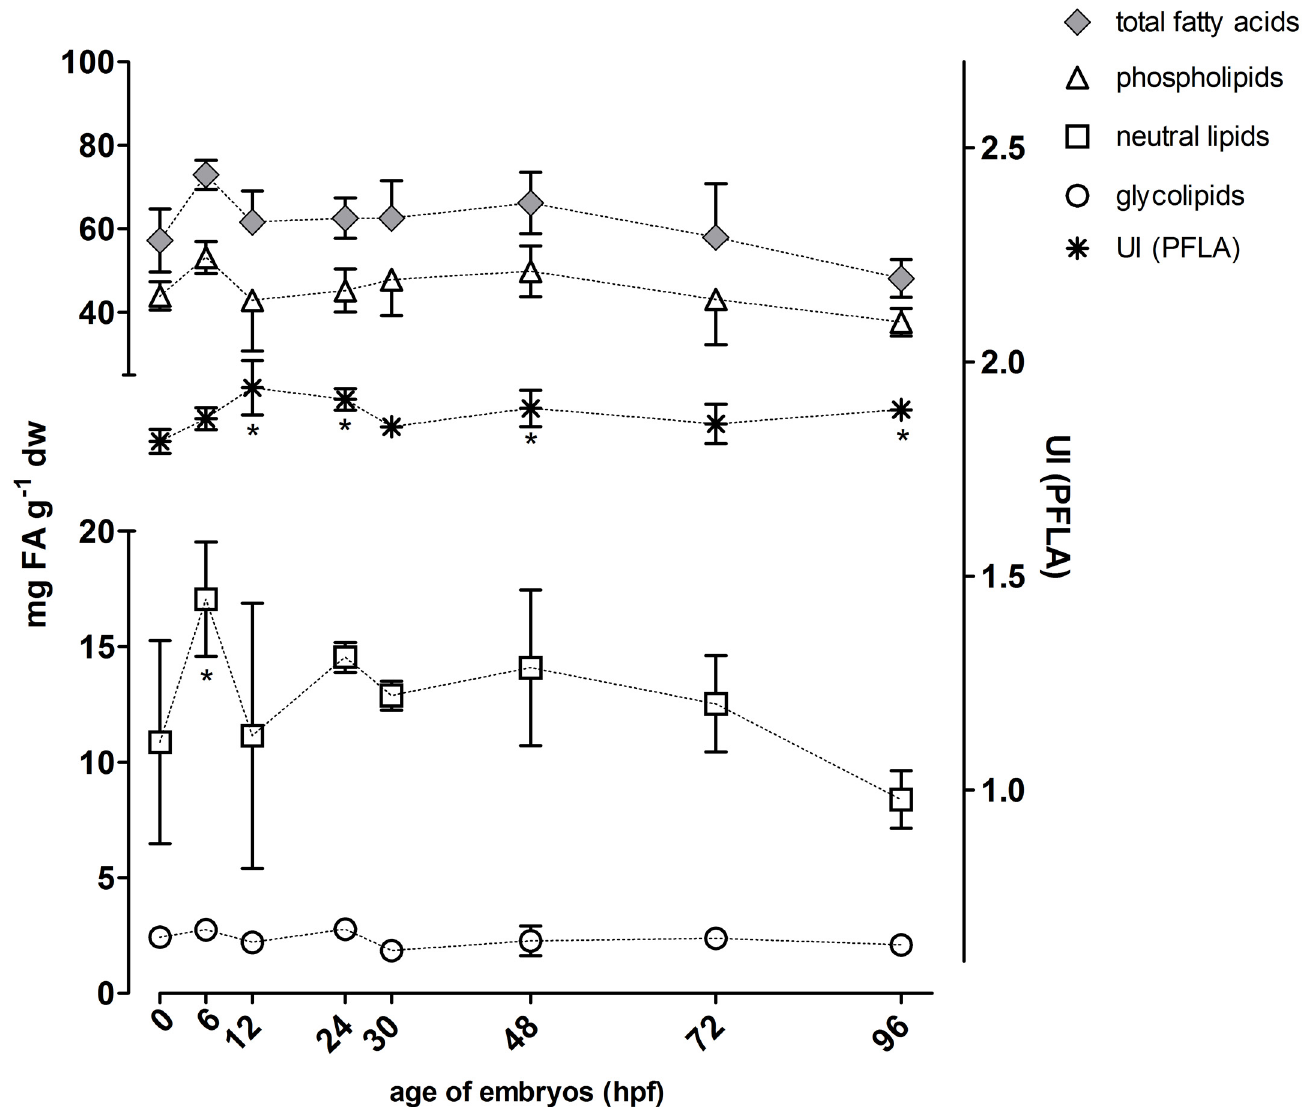
Fig 2. Quantities of different fatty acids (scaled to left y-axis) and the unsaturation index (UI) based on the phospholipids (PFLA) (scaled to right y- axis) for eggs/hatched embryos at 0 – 96 hpf. Total fatty acids, phospholipids, glycolipids and neutral lipids were normalized to dry weight. Symbols were connected to visualize trends. * : p < 0.05 (Dunnett ’ s test with 0 hpf as reference). n = 3 – 4 with 50 pooled individuals per n; hpf: hours post fertilization. Note that the left y-axis is divided into two sections with different scales.